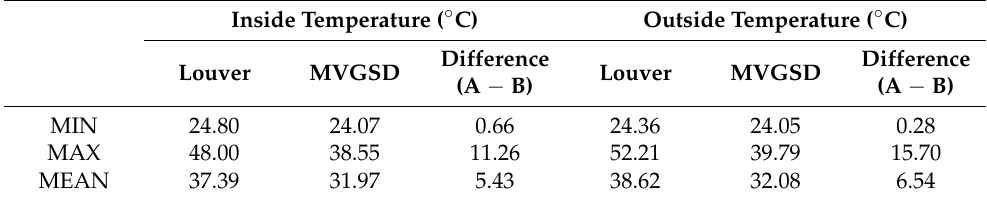
Figure 9. ( a ) Inside temperature of the sunshade; ( b )outside temperature of the sunshade. Table 8. Comparison of sunshade.